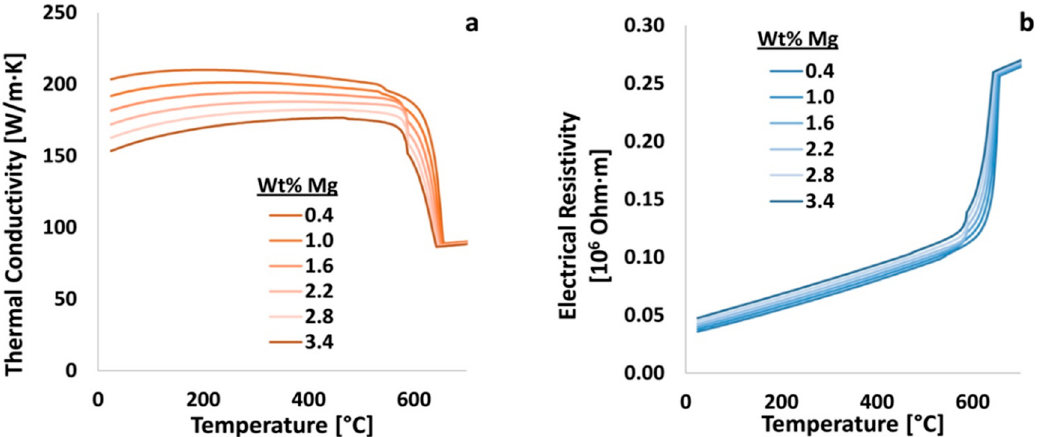
Figure 17. ( a ) The effect of the magnesium content on the thermal conductivity of Al 6061. ( b ) The effect of the magnesium content on the electrical resistivity of Al 6061. of the magnesium content on the electrical resistivity of Al